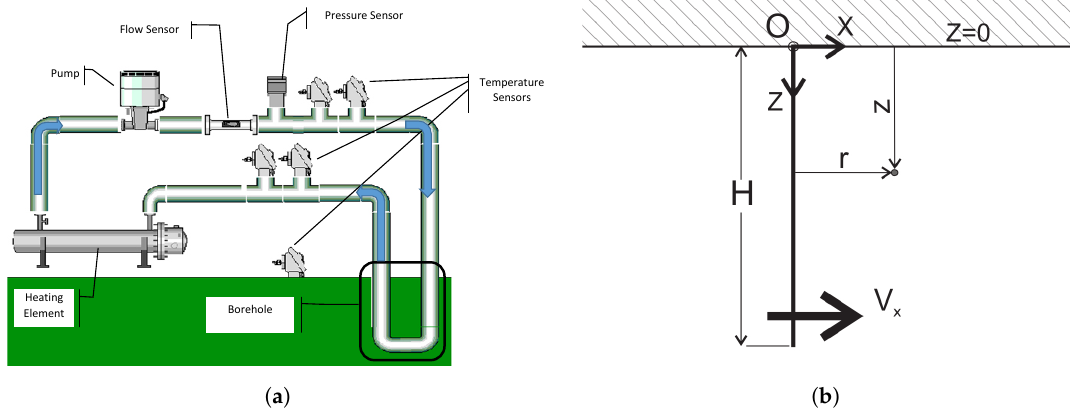
Figure 1. Experimental facility hydraulic system, basic diagram ( a ) (where the arrows indicate water flow direction) and ( b ) coordinate system used as reference for the theoretical